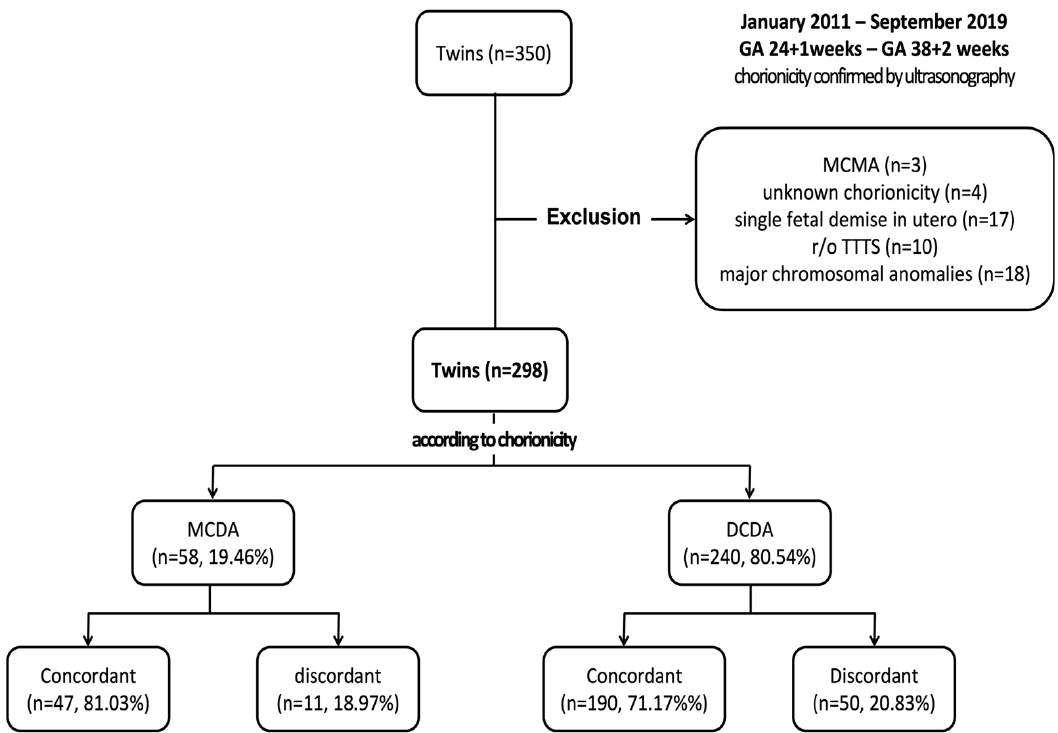
Figure 1. Enrollment process flowchart. DCDA, dichorionic diamniotic; GA, gestational age; MCDA, monochorionic diamniotic; MCMA, monochorionic monoamniotic; TTTS, twin ‐ to ‐ twin transfusion syndrome.